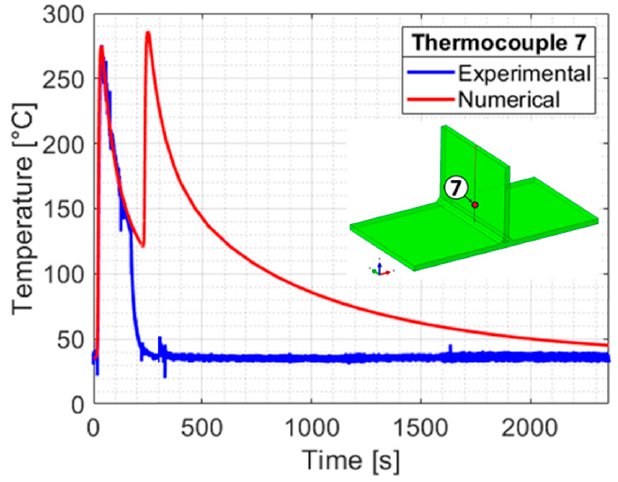
Figure 10. Experimental vs. numerical temperature distribution at the thermocouple location on the web (Point 7).